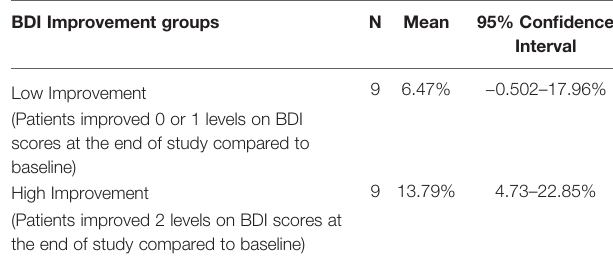
(Patients improved 2 levels on BDI scores at the end of study compared to